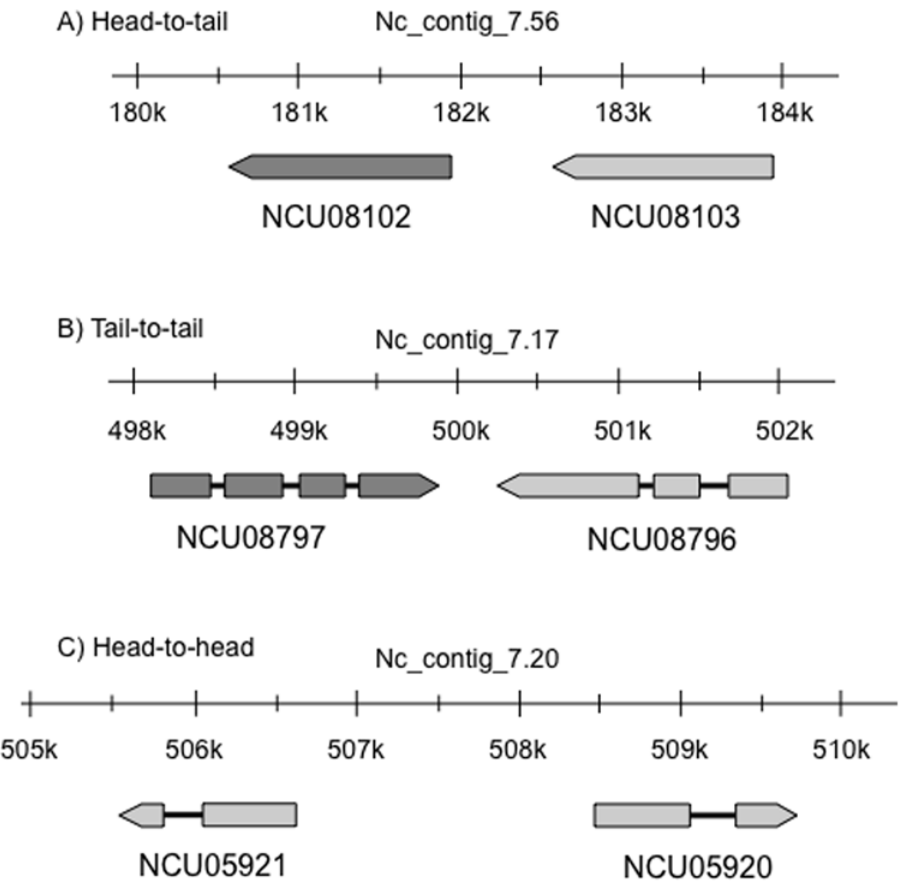
Figure 5. Examples of gene organization of tandem paralogous pairs of N.crassa -orphan PCGs. A) a paralogous gene pair, NCU08102 and NCU08103, shows a head-to-tail gene organization; 73 paralogous PCG pairs have this conformation. B) NCU08797 and NCU08796 are one of five cases of paralogous gene pairs having a head-to-head gene organization. C) NCU05920 and NCU05921 are one of four pairs of paralogous genes that show a tail-to-tail gene organization. Schematic representations are derived from the MIPS Neurospora crassa DataBase (http://mips.gsf.de/genre/ proj/ncrassa/).